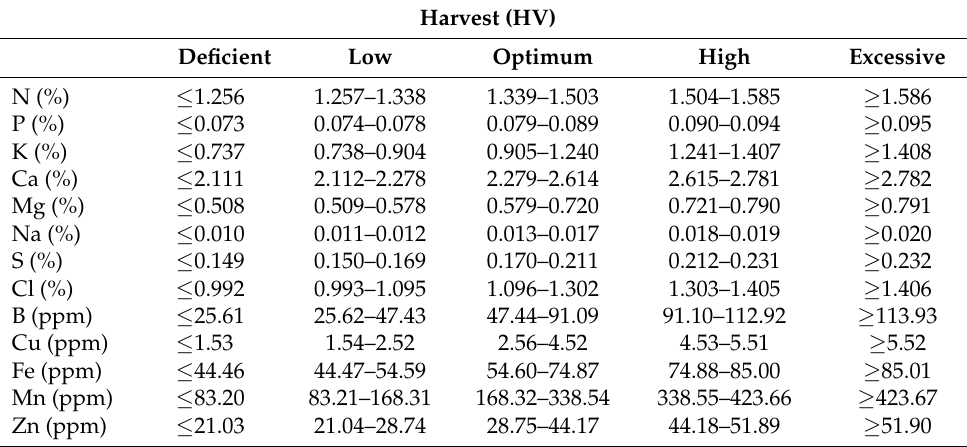
Table 7. Nutrient optimal range (NOR) at HV stage of persimmon fruit in PDO ‘Kaki Ribera del X ú quer’,